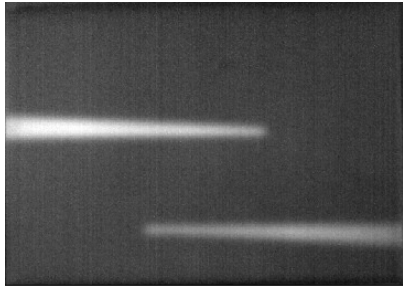
Figure 10. Image composition.